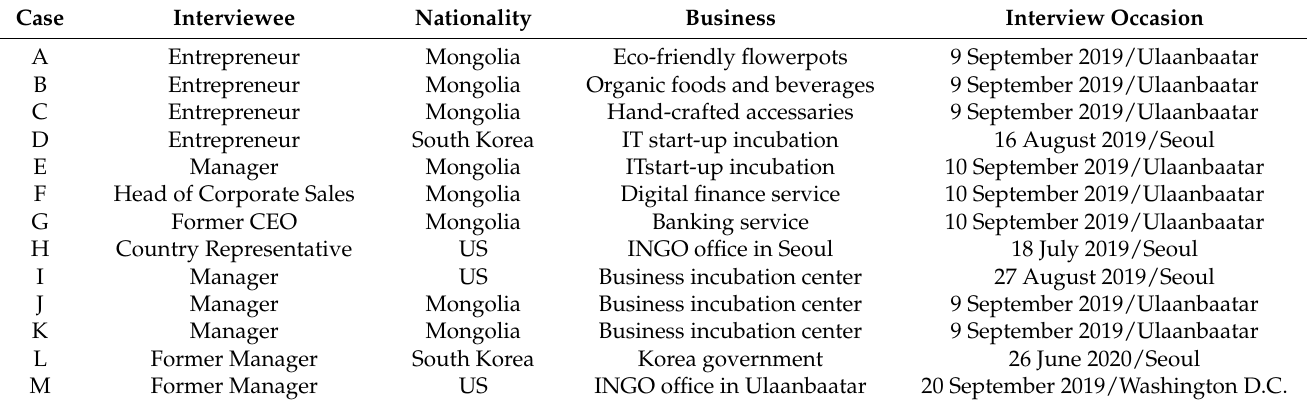
Table 1. Information about the